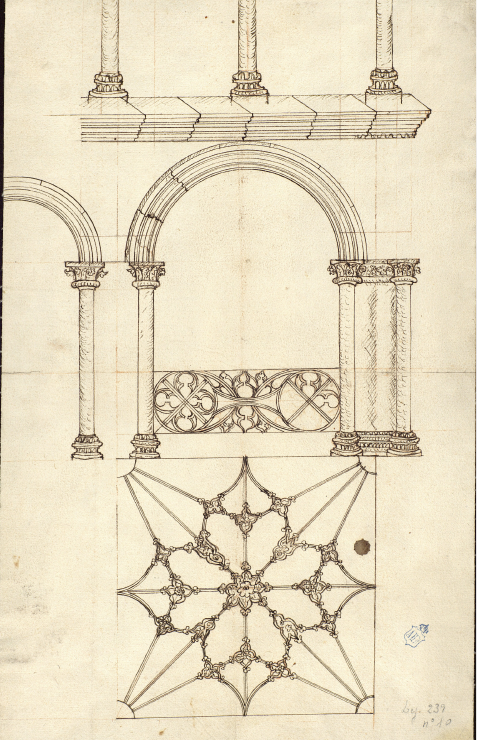
Figure 3. First project for the infirmary cloister of the monastery of Guadalupe (Cáce- res) [A.H.N., Clero, MPD, 18]. © Archivo Histórico Nacional.